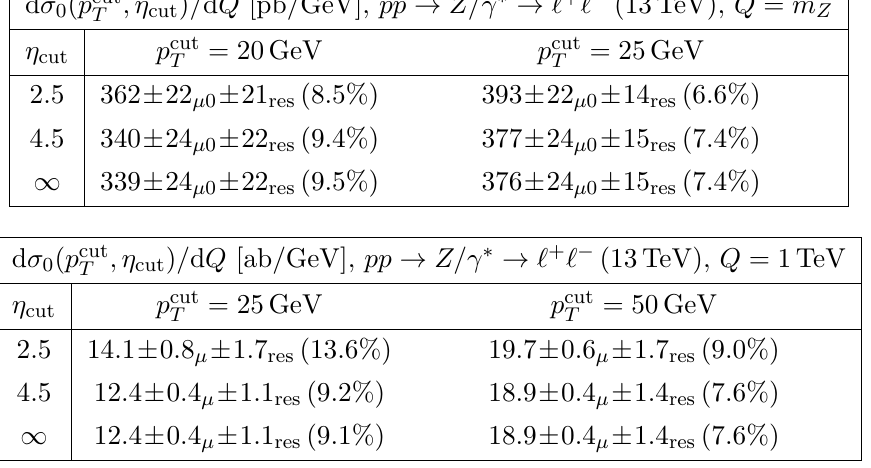
Table 3 . The 0-jet cross section for Drell-Yan production at the Z pole Q = m Z (top) and at Q = 1 TeV (bottom) at NLL 0 +NLO for di(cid:11)erent values of p cut uncertainties.